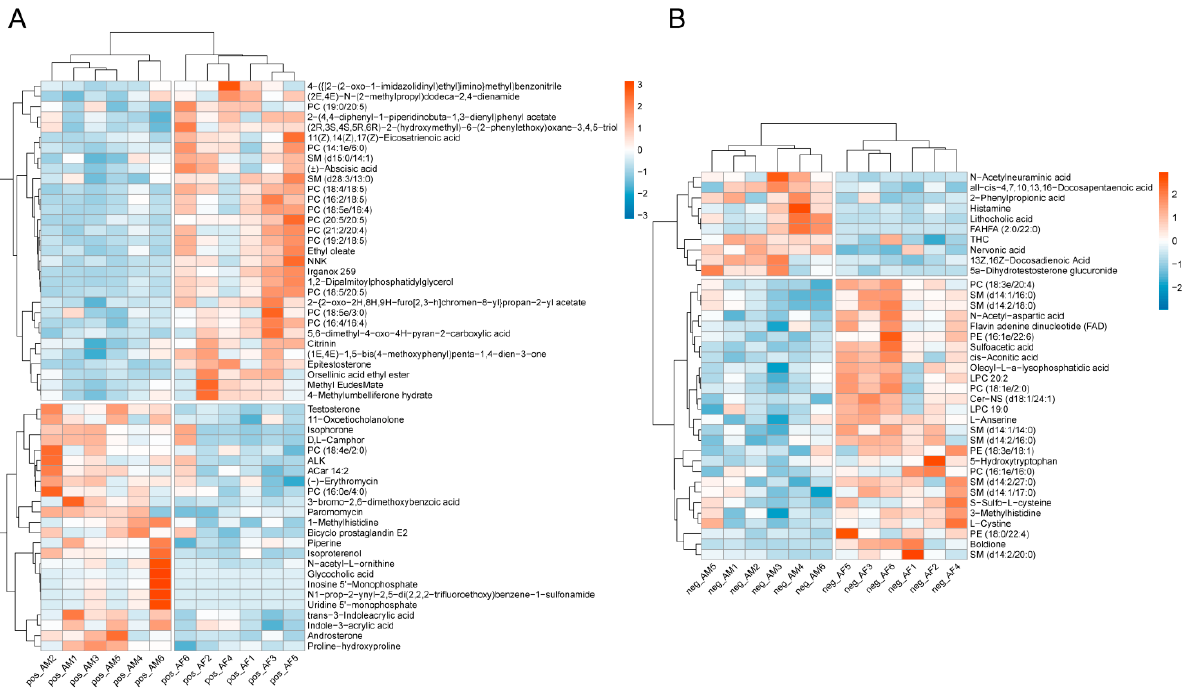
Figure 4. Hierarchical clustering heatmaps of differential metabolites between adult male and fe- male Chinese alligators in positive ( A ) and negative ( B ) ion modes. AM: adult male; AF: adult fe- male.